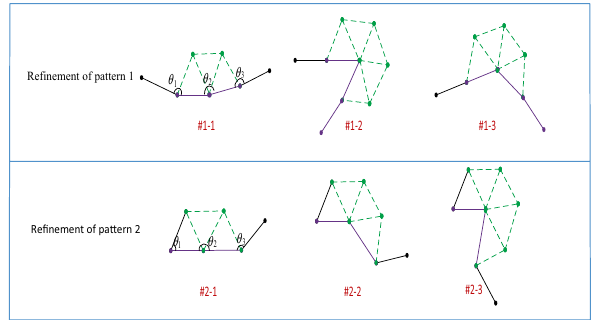
Figure 5. Refinement of some patterns based on knowledge rules.